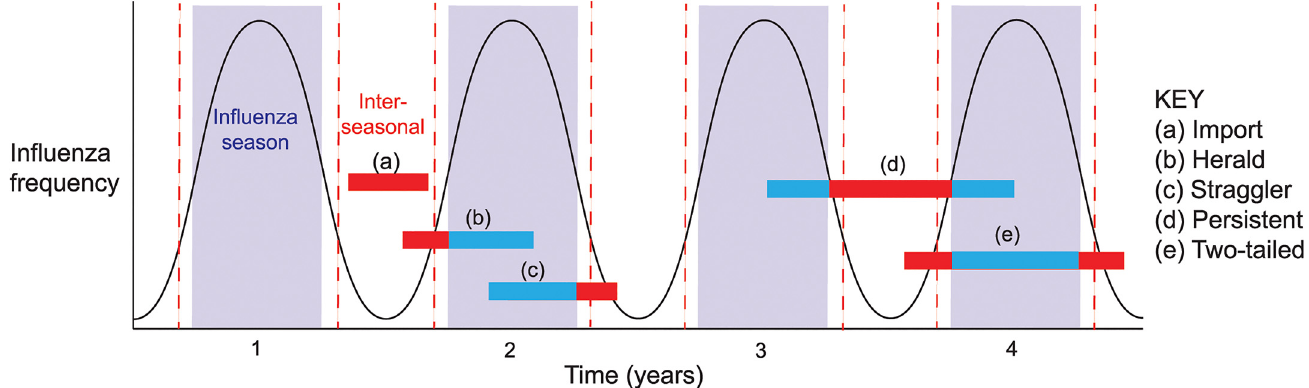
Fig 2. Patterns (event types) of inter-seasonal influenza transmission. The black line represents the theoretical periodicity of influenza in a typical seasonal pattern, horizontal bars represent lengths of transmission events and are colored blue when falling inside the season and red when in the inter- seasonal